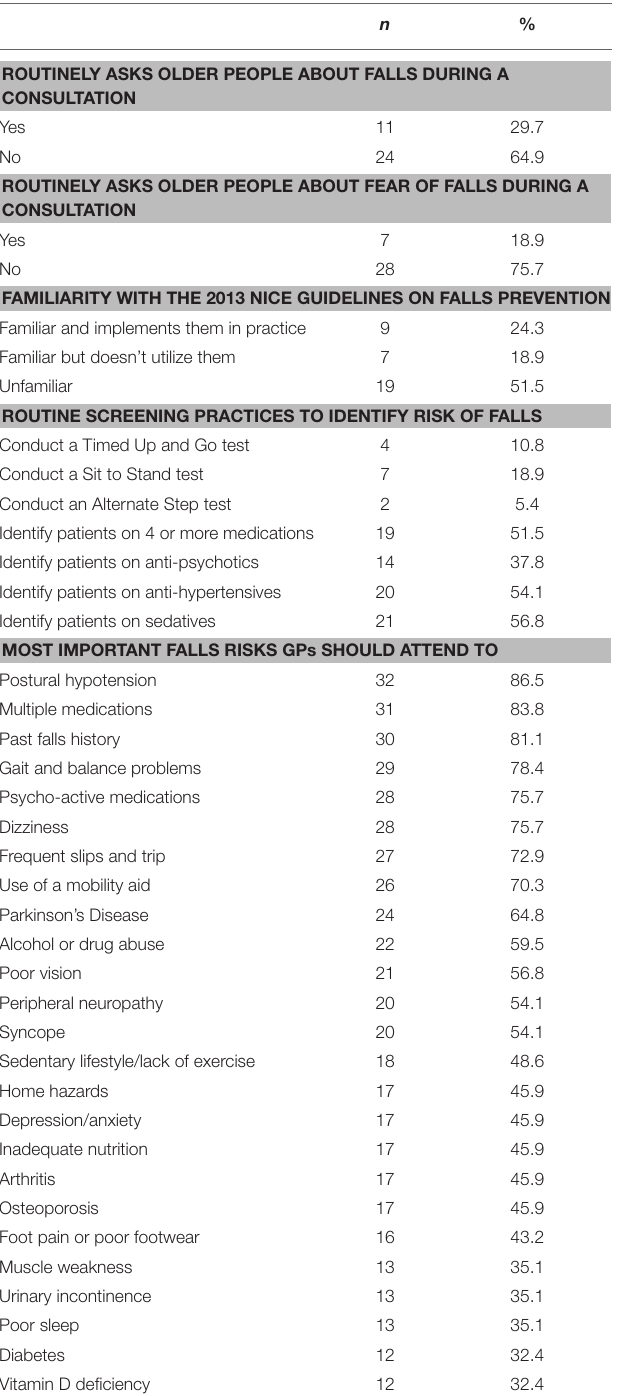
TABLE 3 | Falls prevention practice and opinions of GPs ( N = 37).